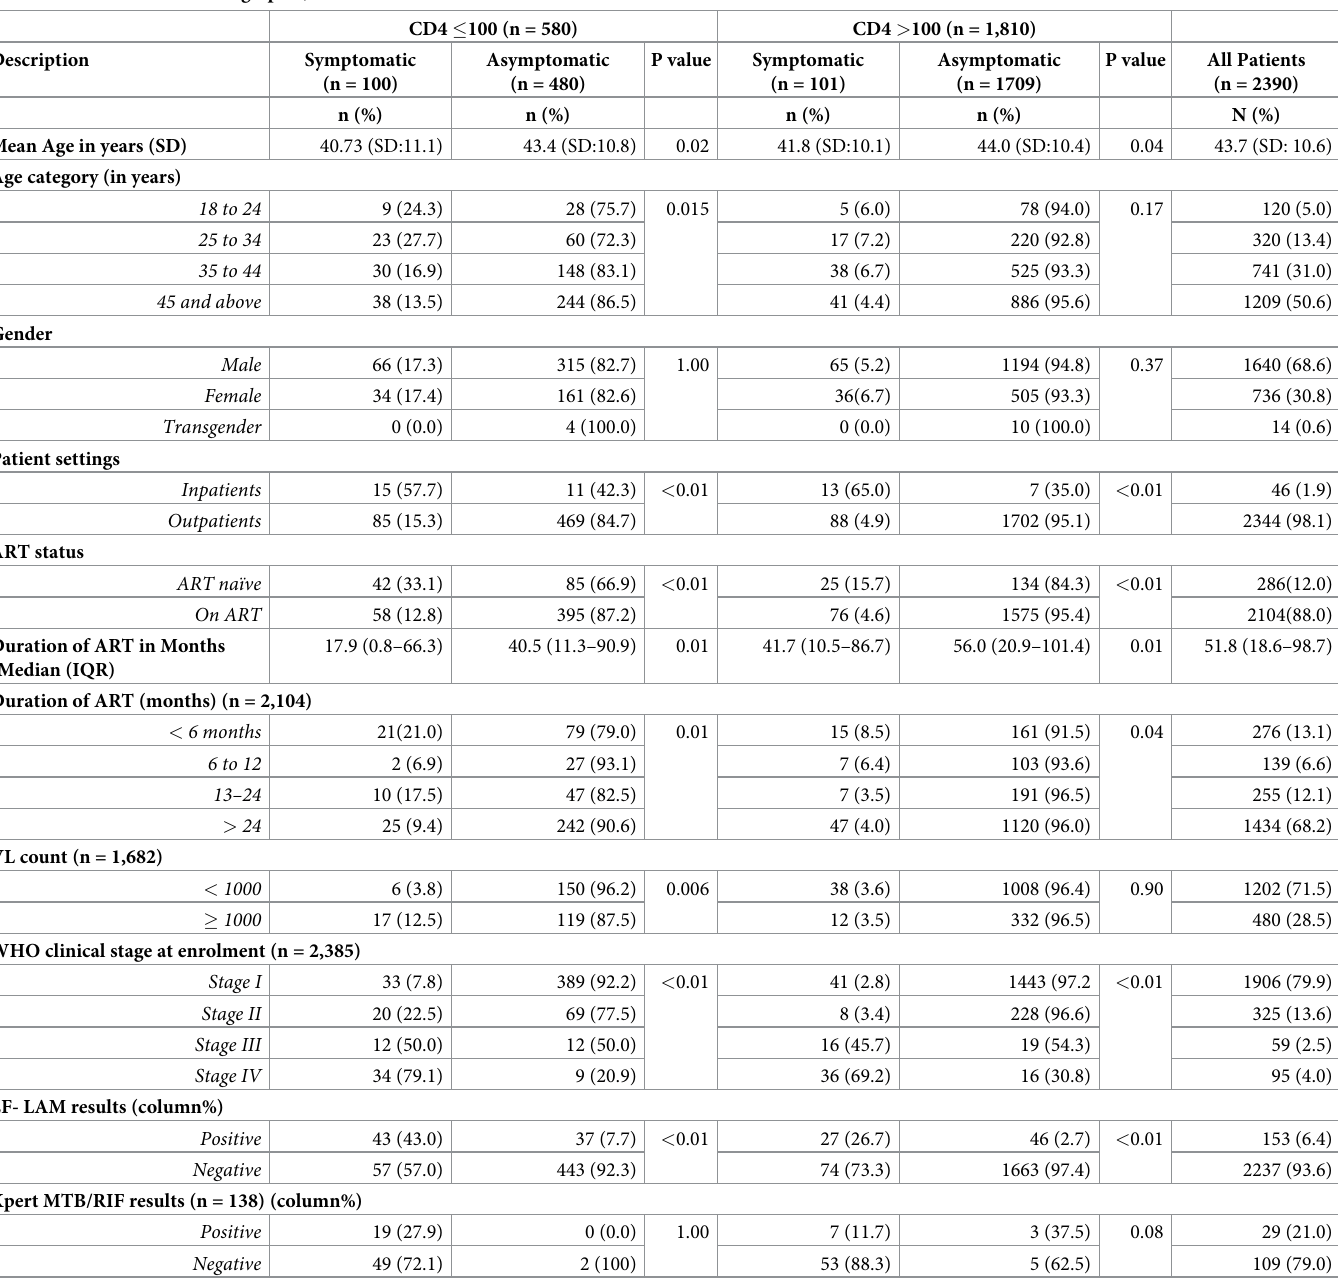
Table 2. Distribution of demographic, clinical and treatment